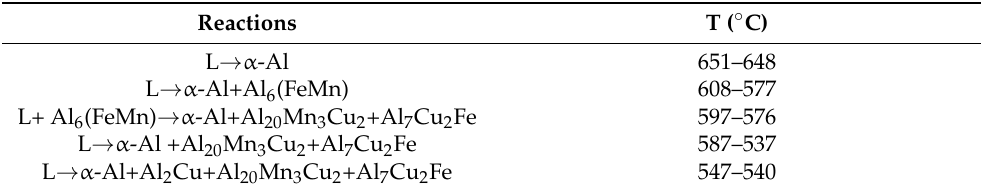
( d ) Figure 11. Phase fraction vs. temperature curves of 2219 Al–Cu alloy with different Fe contents calculated by the software JMatPro 7: ( a ) 0.03 wt.%; ( b ) 0.1 wt.%; ( c ) 0.15 wt.%; and ( d ) 0.2 wt.%.